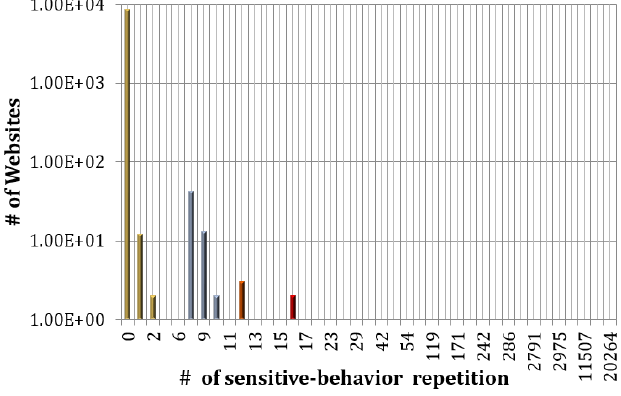
Figure 13. Amount of websites that match pixel-based timing probing attack patterns for a certain